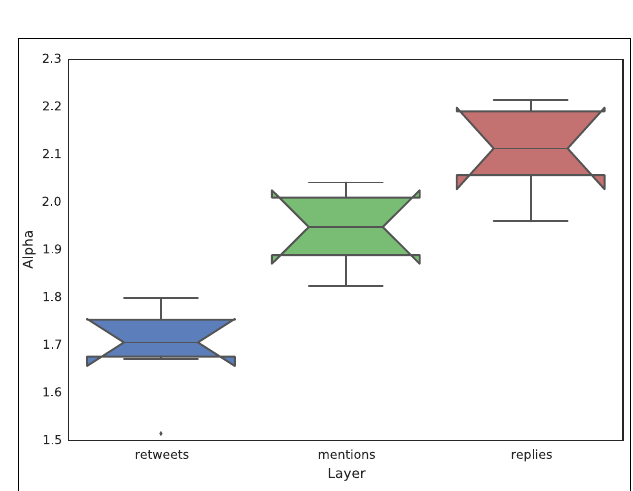
FIGURE 6 | Notched box plots showing the value of the scaling exponent of the in-degree distribution for each layer. Each box aggregates the values corresponding to the different events considered. Notched box plots present a contraction around the median, whose height is statistically important: if the notches of two boxes do not overlap, this offers evidence of a statistically significant difference between the two medians. This is the case here, meaning that the median scaling exponent of the in-degree distribution of each of the three layer is different from the exponent characterizing the in-degree distribution of the other